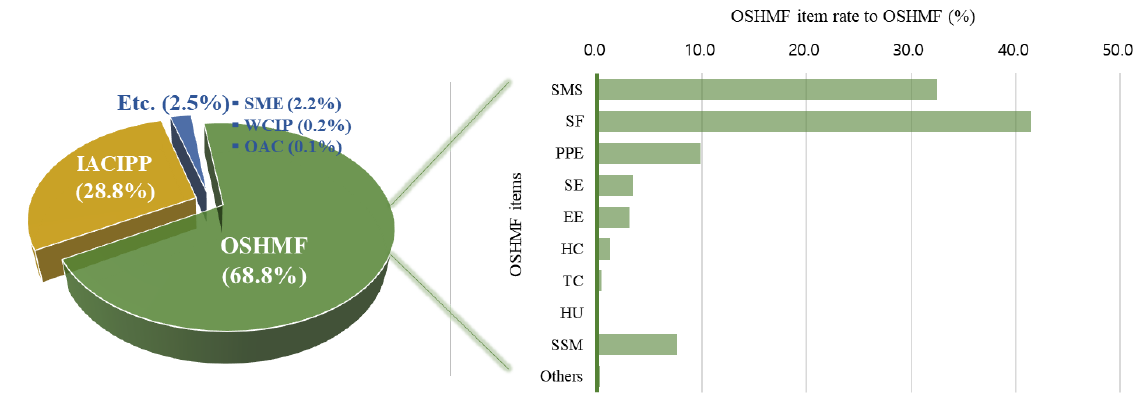
Figure 5. Component ratio of APC and OSHMF item rate to OSHMF. Table 9. Ratio analysis result by OSHMF items to TCC.